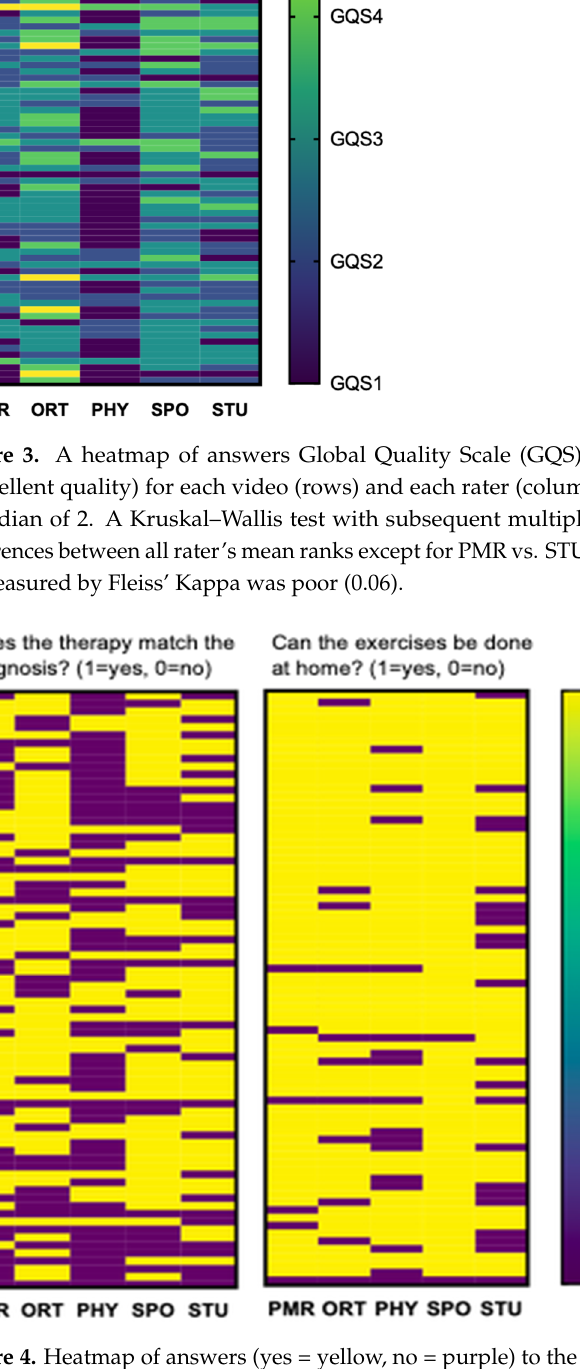
Figure 4. Heatmap of answers (yes = yellow, no = purple) to the questions “Does the therapy match the diagnosis?” (left panel) and “Can the exercise be performed at home?” (right panel). The heatmap displays significantly divergent answers (modified Chi-Square test p > 0.001) to each video (one video = one row) from each rater (one column = one rater). In absolute terms, raters agreed unanimously more often on “Home” (52 of 72 answers) than on “Match” (5 of 76 answers). Rater agreement was estimated to be poor regarding all quality scores employed in this study. Rater agreement on GQS was measured by Fleiss’ Kappa for multiple raters and estimated at 0.06 ( p = 0.002) for all values of GQS and even lower for low values of GQS (see Appendix A, Table A1). For the Discern tool (kappa = −0.003, p = 0.867), JAMA score (kappa = −0.016, p = 0.508) and overall grades (kappa = 0.052, p = 0.009), raters dis- played a similar agreement with a tendency of higher (but still poor) kappa-values around medium values and less agreement on the fringes. 4. Discussion Beyond all doubt, the internet has become an essential and easily accessible source of information for a patient, as various authors have reviewed previously [26,32,33]. Never- theless, it has also been shown that patients are concerned in regard to the reliability and validity of the provided information on the internet [28,29,33]. YouTube (Alphabet, Mountain View, CA, USA) is one of the most popular and influential websites on the In- ternet with approximately 73% of U.S. adults using YouTube [26,30,31]. However, consid- ering that the uploaded content does not undergo a peer-review process the quality and scientific soundness of the content remain unclear [26]. Numerous previous studies have determined the overall quality of information of YouTube videos in various medical subspecialities and moreover in the field of orthope- dics to be insufficient or rather poor [26,30,33,39–41]. Kocyigit et al. assessed the quality of ankylosing spondylitis exercise videos available on YouTube, however to our knowledge no previous study has assessed the quality of physiotherapy tutorial videos on YouTube for patients with lumbar disc herniation [33]. Hence, the evaluation of these publicly available videos appears even more crucial in the light of the ongoing pandemic. The COVID-19 pandemic has led to demanding challenges in treating and diagnos- ing patients with spinal disorders such as lumbar disc herniation [22,23,25]. Meanwhile